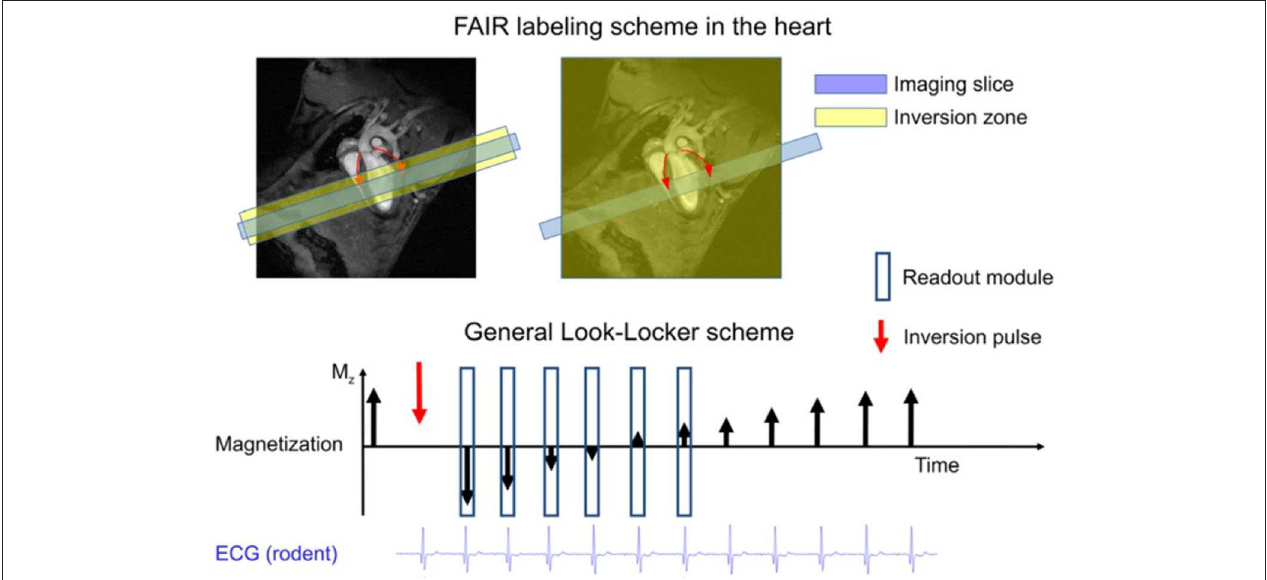
FIGURE 6 | The FAIR labeling scheme ( upper part) consists of two inversion recovery measurements. In the first measurement the labeled zone is only around the imaging slice, and in the second measurement the inversion is global. FAIR is the most commonly used ASL technique in the heart. The timing of the inversion and that of the readout modules should be ECG-gated and occur in the same cardiac phase. The Look-Locker inversion-recovery readout ( lower part) has been used mainly in the rodent heart, where the rapid heart rate permits dense sampling of the magnetization recovery curve. Reproduced with permission from Kober et al. [